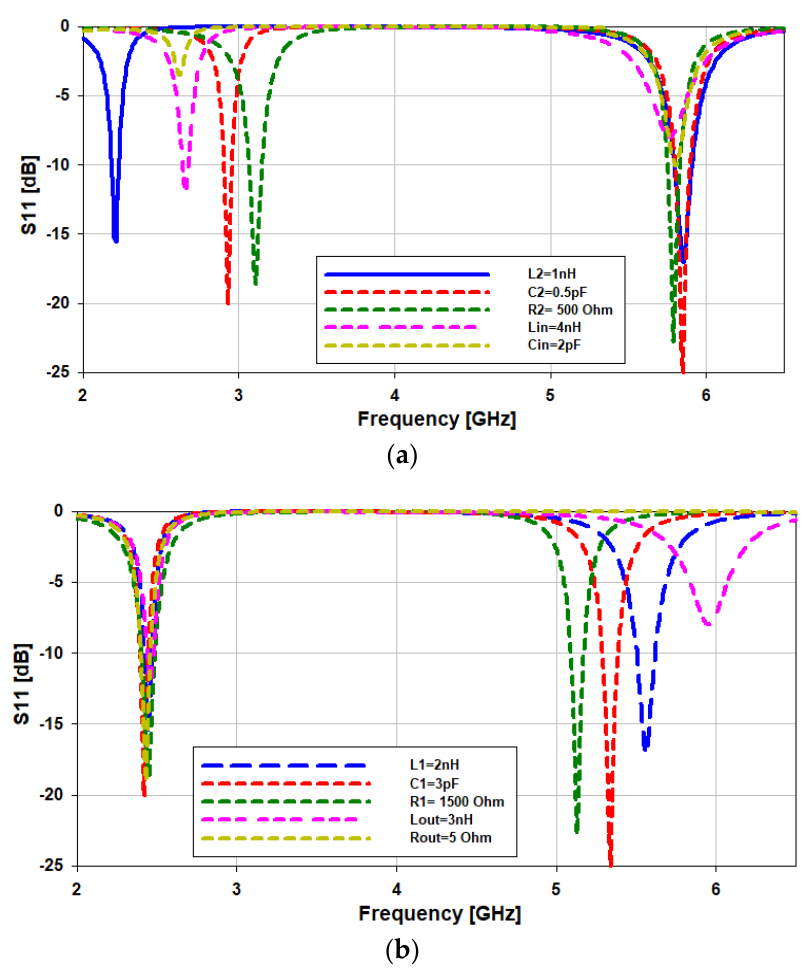
Figure 8. ( a ) Optimization of the circuit components for the lower frequency band and ( b ) the higher frequency band.